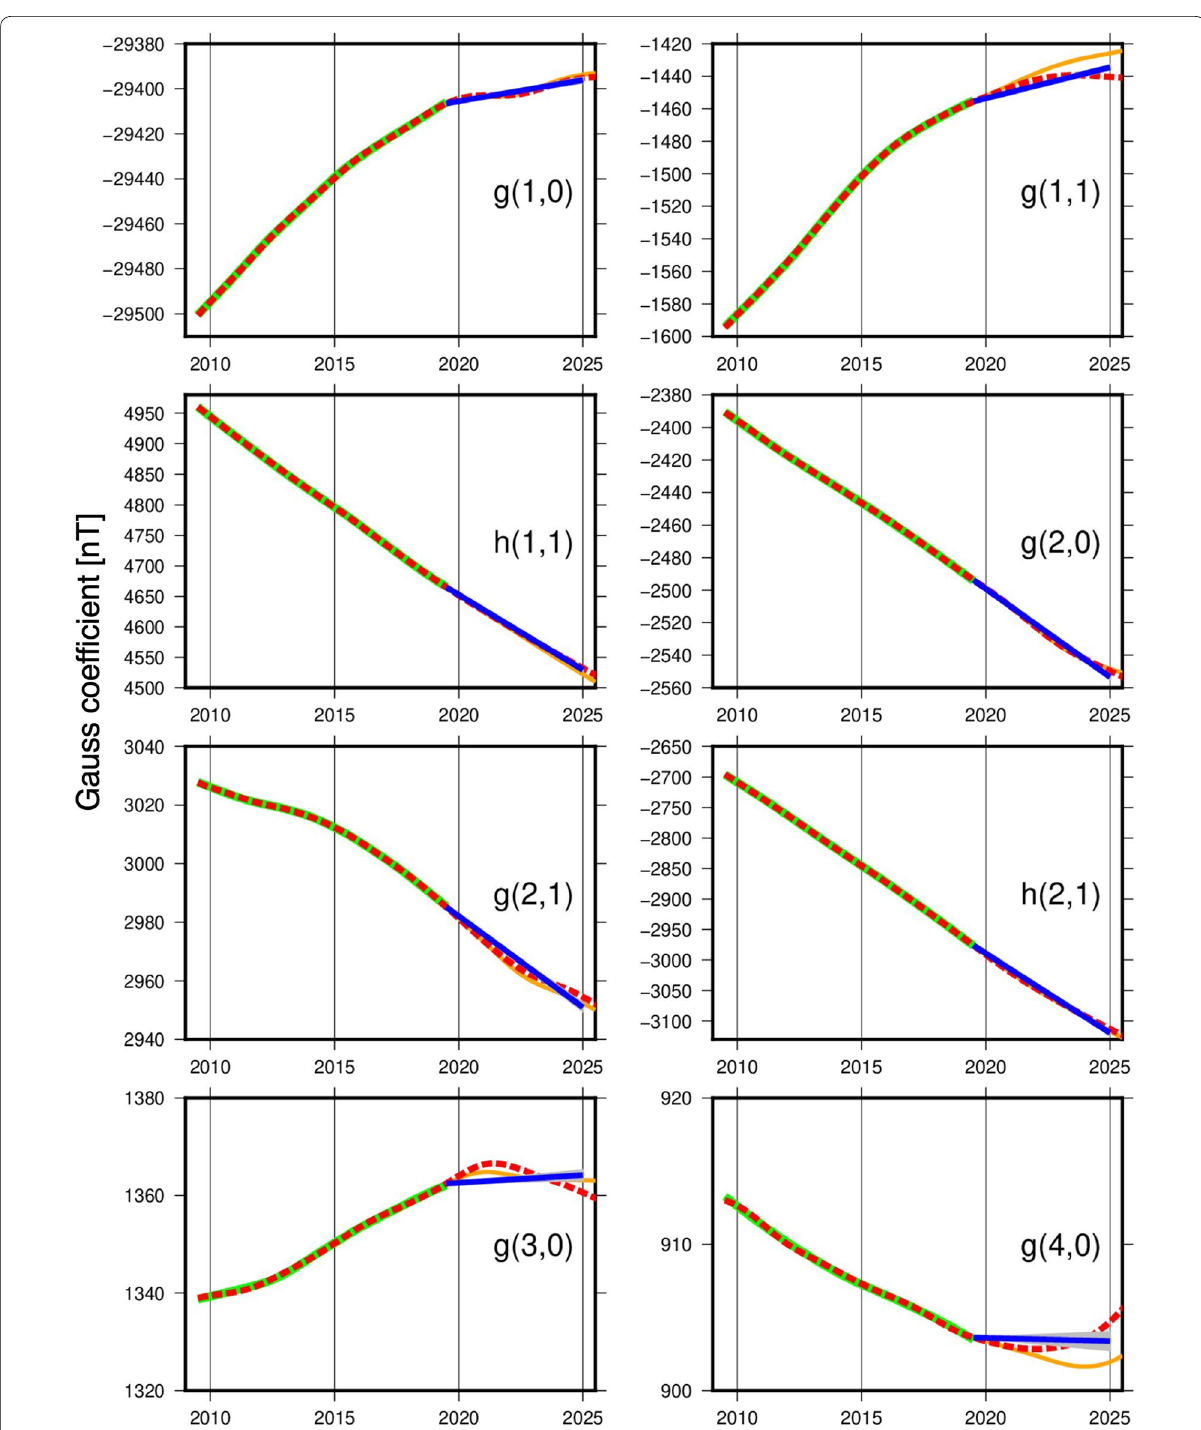
Fig. 9 Comparison of Gauss coefficients between the final SV of our candidate model (the blue lines) and the forecasts by the Ens. wei. sum by Eq. (13) (the red dashed lines). The gray shadow areas behind the final SV correspond to the error provided in our SV model. The green solid lines behind the red dashed line denote the MCM6 model. The orange lines show time evolution of Gauss coefficients obtained from the MHD dynamo simulation with the initial condition at the end of the assimilation window, 2019.25 (the MHD forecast with k ′